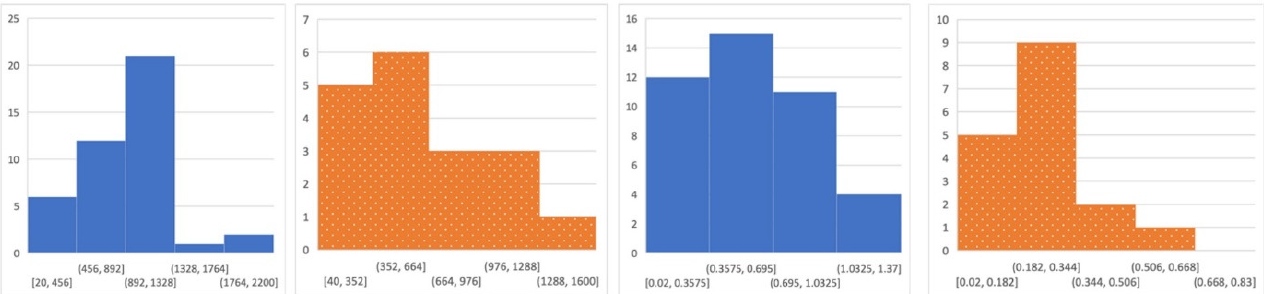
Figure 1. Histograms of milk yield (left) and milking speed (right) for calm (blue) and nervous (orange) buffalo cows.